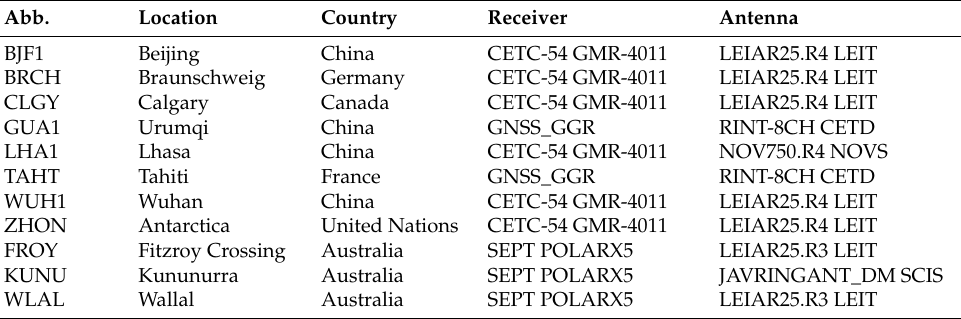
Figure 1. Ground traces of BDS-3 satellites and distribution of the tracking stations used in this study. Stations capable of tracking BDS-3 satellites are marked in blue. The other stations are marked in red. Table 2. GNSS monitoring stations with BDS-3 tracking capability.